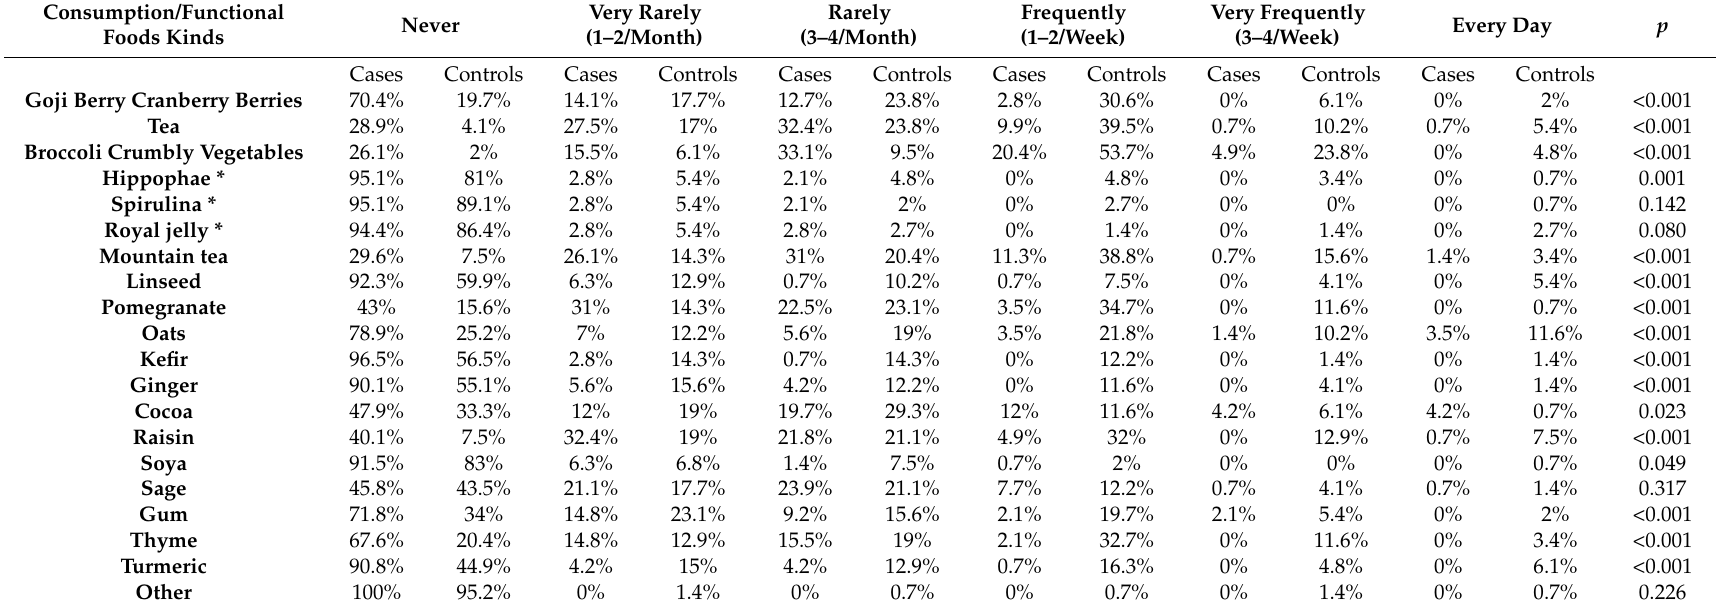
Table 3. Cases–controls comparisons in relation to the consumption frequency of functional foods